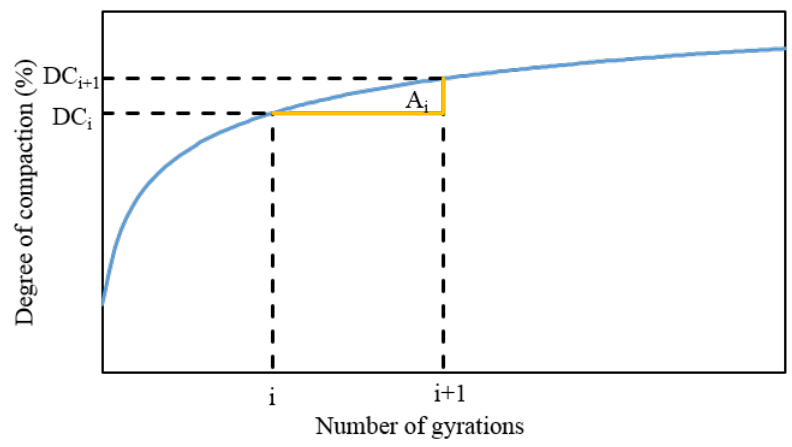
Figure 3. The area of the adjacent number of gyrations under the compaction curve.